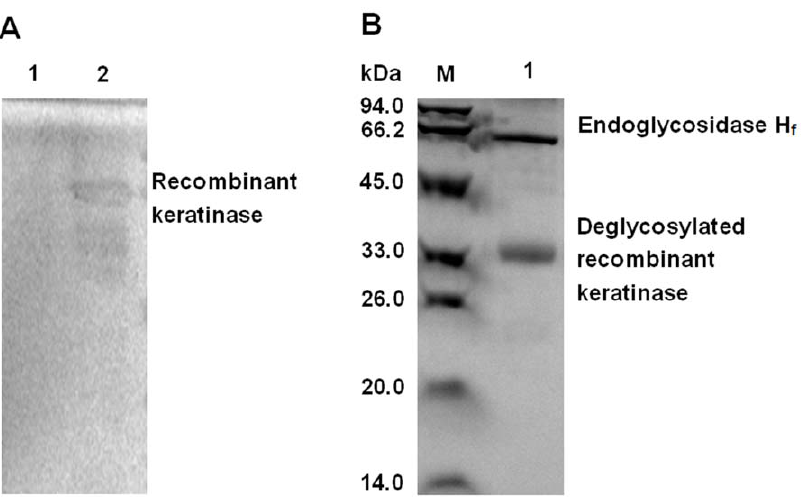
Figure 4. The glycoprotein staining and deglycosylation of purified recombinant keratinase in the SDS-PAGE. A: The glycoprotein staining experiment. Lane 1: BSA; Lane2: purified glycosylated keratinase. B: The deglycosylation of purified recombinant keratinase. Lane M: protein MW markers (14–94 kDa); Lane 1: deglycosylated keratinase.